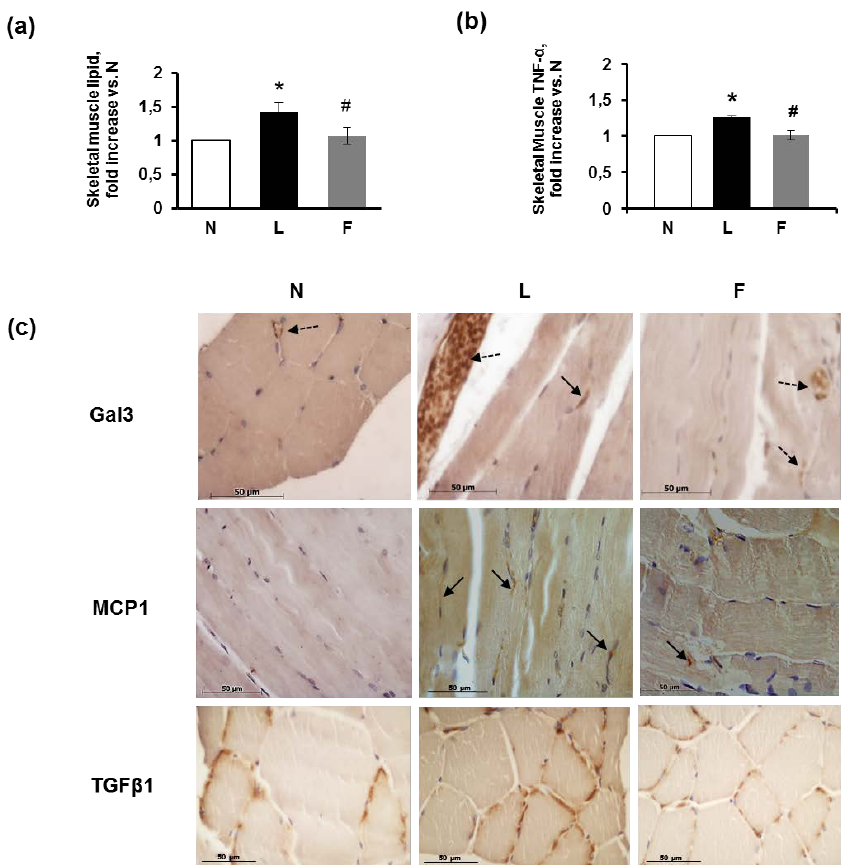
Figure 3. Skeletal muscle fibre analysis in rats fed a control diet (N), high-lard diet (L) or high-fish oil diet (F). ( a ) Lipid content in the skeletal muscle; ( b ) TNF-α levels in skeletal muscle; ( a , b ) The data are reported as fold increase vs. N rats ( N = 1) and represent the means ± SE for 8 rats in each experimental group. * p < 0.05 compared with N rats; and # p < 0.05 compared with L rats; ( c ) Immunostaining in the N, L and F histological sections. Gal3: In the N rats, the immunostaining for this lectin was observed only in the endothelial cells of blood vessels (dashed arrow); in L, positive cells for Gal3 was localised near muscle fibres (arrow). Notably, the blood vessels of the endomysium that service the muscle fibres were filled with Gal3-positive cells, suggesting a switch from M2 to M1 macrophages (dashed arrow). In the F group muscle fibres, several positive cells were found in the blood vessels (dashed arrows). MCP1: N fibres did not demonstrate immunostaining for this cytokine, in contrast to the L and F muscle fibres. Arrows indicate cells (likely M1 macrophages) positive for MCP1. TGFβ1: Cells positive for TGFβ1 were found in all N, L and F sections and were localised around the muscle fibres; in particular, L fibres presented stronger